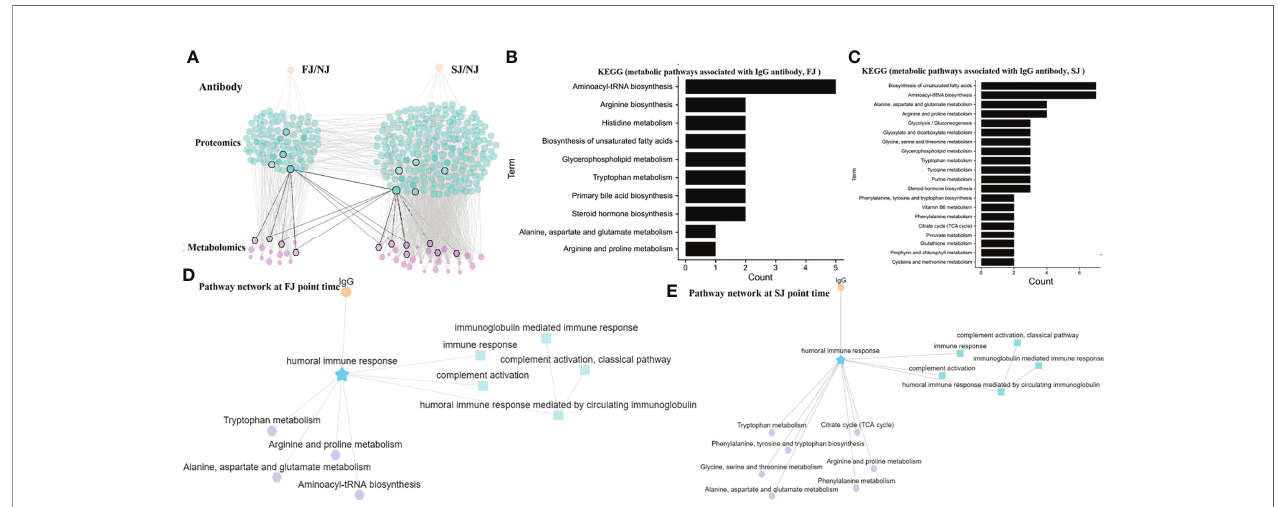
FIGURE 6 | MRN analysis of Metabolomics, Proteomics, and Antibodies. (A) MRN consists of correlation networks using data from antibody, DEPs, and DEMs. Each node is a child network of one data type. The links between nodes were established by weight. (B) The top 10 pathways for metabolite networks correlated with IgG levels at FJ time point. (C) The top 20 pathways for metabolite networks correlated with IgG levels at SJ time point. (D) Connections between IgG, humoral response associated network and metabolite networks at FJ time point are shown. (E) Connections between IgG, humoral response associated network and metabolite networks at SJ time point are